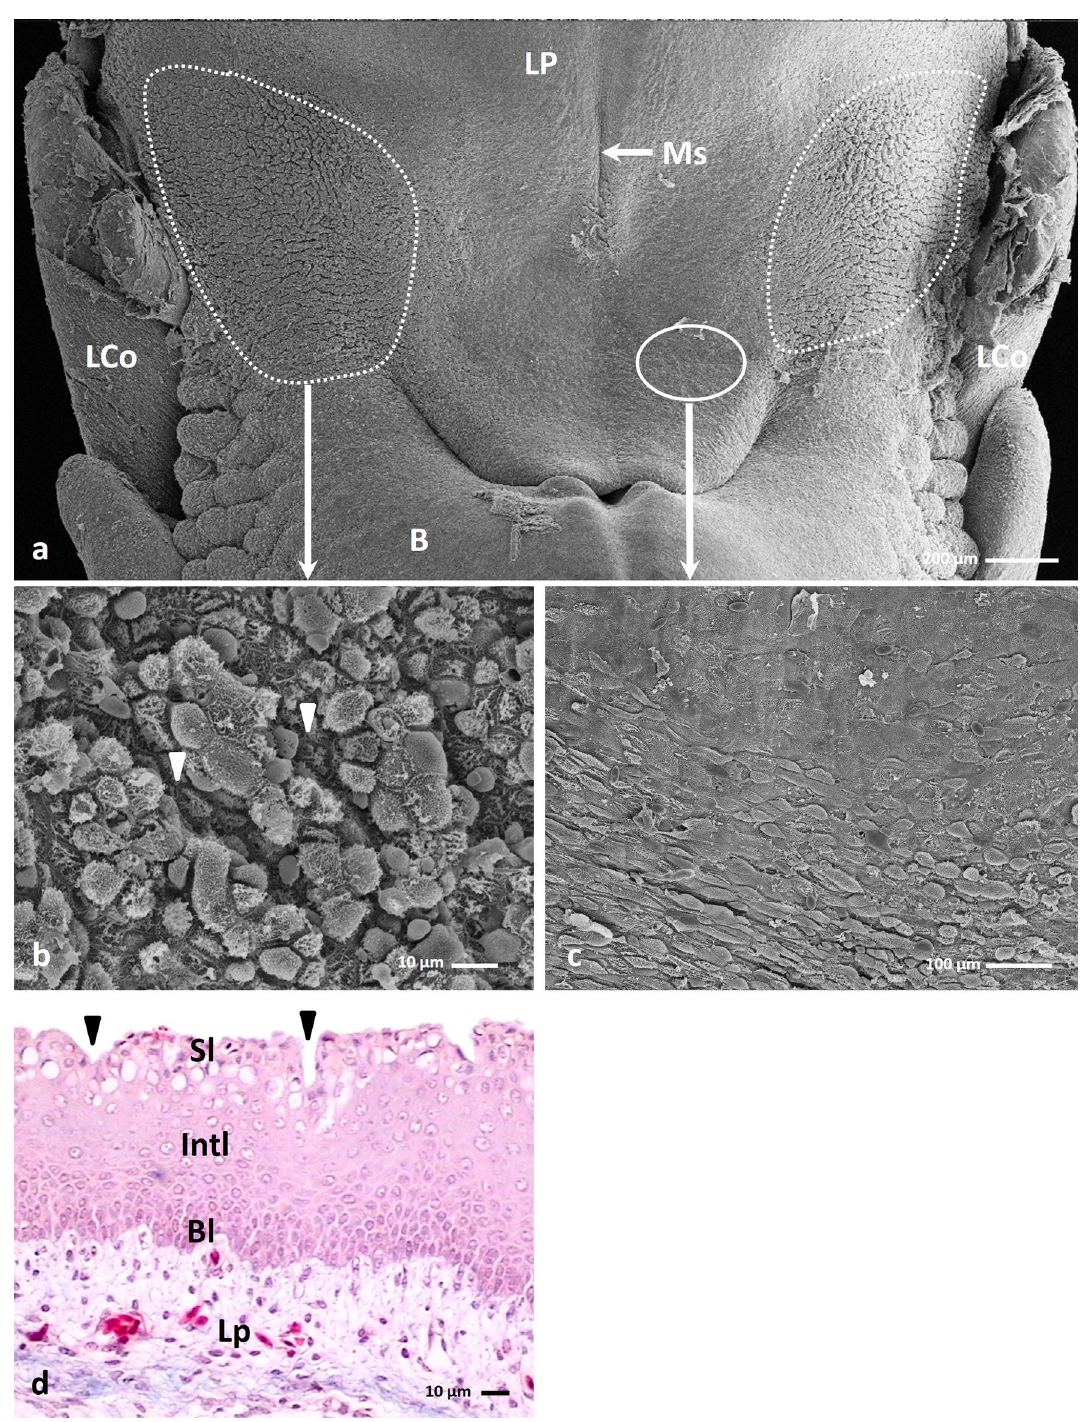
Figure 7. ( a ) 24th day of incubation. View on the dorsal surface of the lingual prominence with flat medial area (circle) and shallow furrows on the lateral areas (dotted line). B-body of the tongue, LP-lingual prominence, Ms-median sulcus, LCo-large conical papillae. SEM. ( b ) 24th day of incubation. Higher magnification of the surface of the epithelium on the lateral area of the lingual prominence with shallow furrows arrange perpendicular to the long axis of the tongue (arrowheads). SEM. ( c ) 24th day of incubation. Higher magnification of the surface of the epithelium on the flat medial area of the lingual prominence without furrows. SEM. ( d ) 24th day of incubation. Cross section of the epithelium of the lateral area of the lingual prominence with shallow furrows (arrow heads). Bl-basal layer, Int-intermediate layer, Lp-lamina propria, Sl-superficial layer. LM. Masson–Goldner